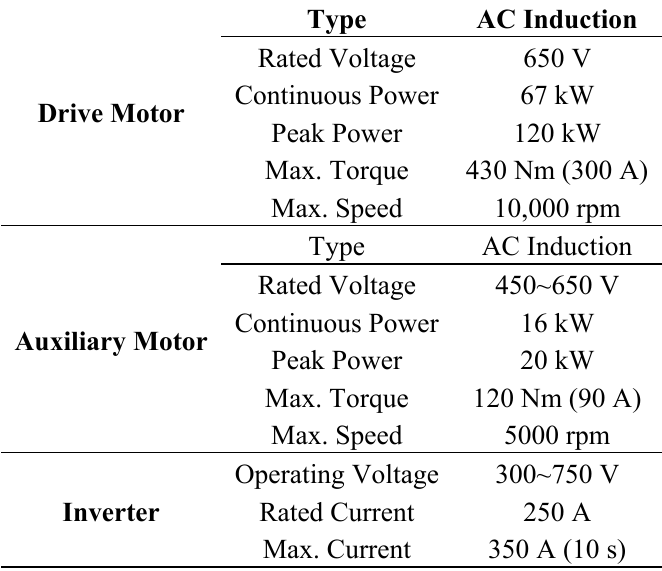
Table 2. Specifications of the electric